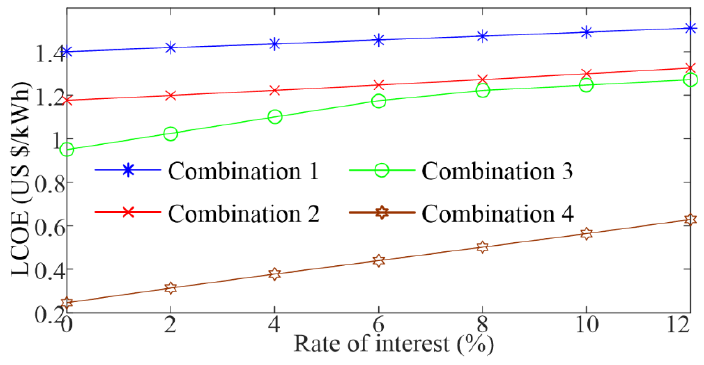
Figure 20. Variation of LCOE with variation in the rate of